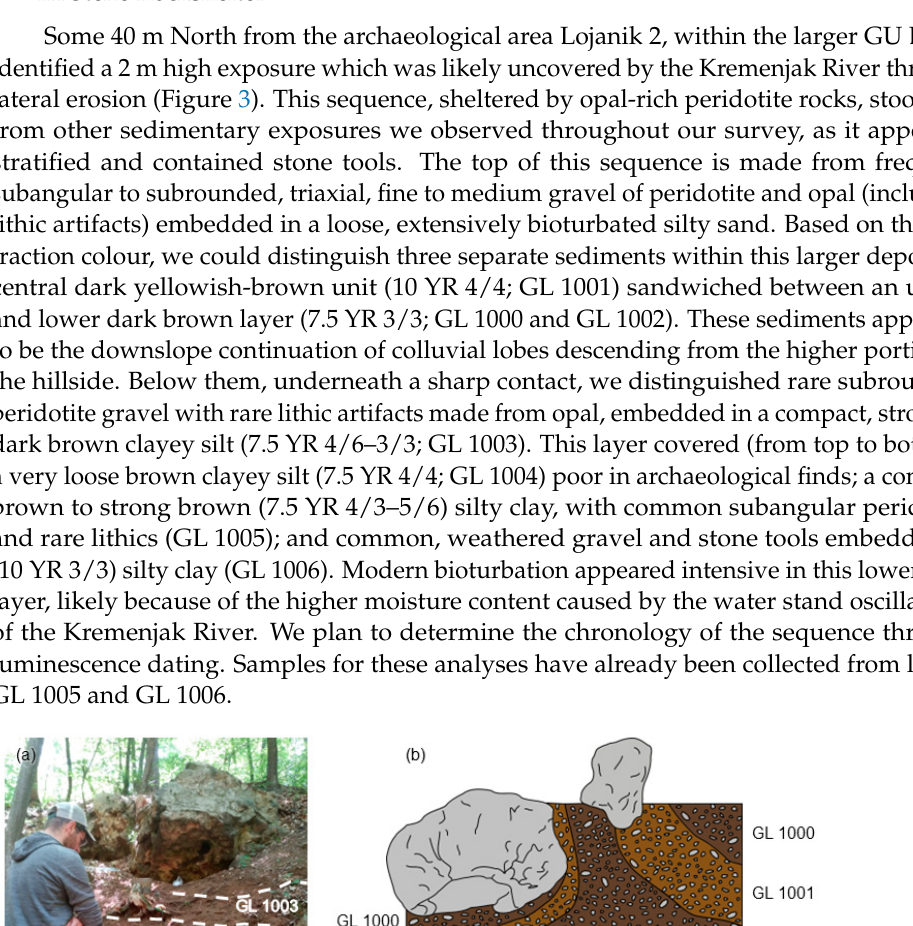
Figure 3. Stratigraphic data: ( a ) Tri Stene Rockshelter during luminescence sampling, analysis un- derway; ( b ) Schematic drawing of the lithological units and location of key archaeological materials identified at Tri Stene Rockshelter; ( c ) Schematic cross-section drawing from Geo-trench 1. c. Electrical resistivity tomography To gain insights into the nature of features detected during our geomorphological mapping (such as breaks-in-slope and potential bedrock outcrops) and collect preliminary data about the formation of Kremenjak and Lojanik 1 valleys, we acquired ERT data along freely oriented lines. Across the western flank of the Kremenjak Valley, we detected a laterally continuous, stratified sequence (Figure 4). From top to bottom, we identified a potential lithological unit exhibiting resistivity between 1.8 and 3 log10 Ω m (ERT-A). This body outcrops at the ground surface and reaches a maximum depth of 3 m. Considering electrical properties [66,67] and location across the slope, ERT-A likely corresponds to the numerous opal rich peridotite rocks we observed during our geomorphological mapping in the archaeological areas Lojanik 2 and 3. Our ERT data demonstrate that these rocks are not bedrock outcrops but rather loose boulders, which likely accumulated during rockfalls. Underneath ERT-A, we documented a resistive unit (1.4 to 1.8 Ω m; ERT-C) sand- wiched in between two conductive layers (0.7 to 1.1 Ω m; ERT-B and ERT-D). Based on published reference data [60,68–71], we interpret these potential lithological bodies as boulder/gravel- and clay-rich sediments, respectively. The geometry of these deposits ap- pears to be better resolved in the 1 m spaced tomographies. In particular, in ERT-3, these